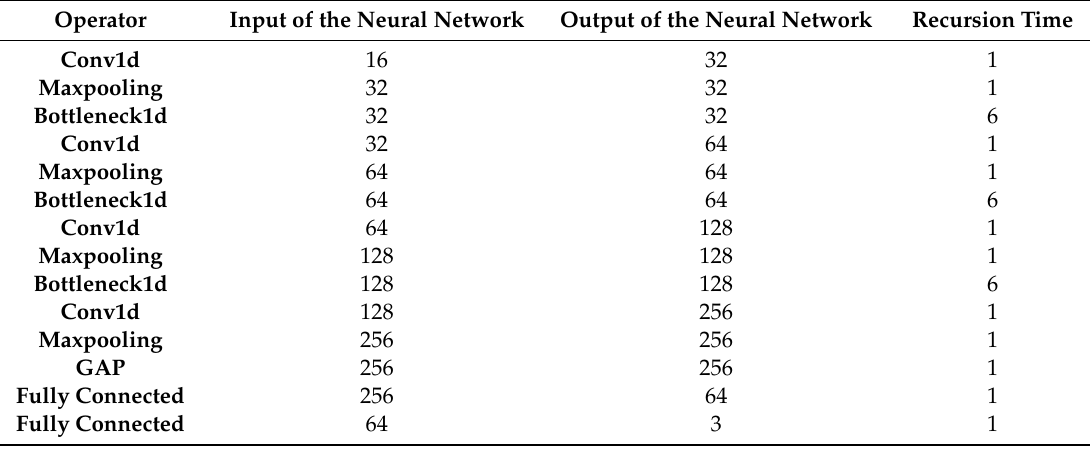
Table 2. The model configuration of a neural network.